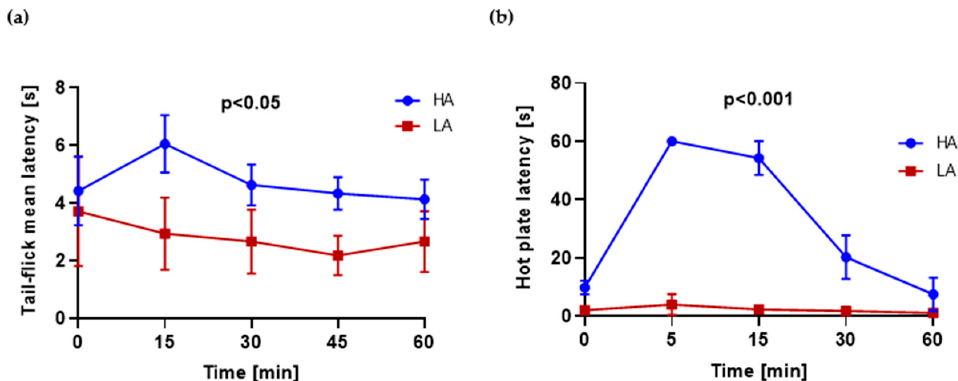
Figure 1. ( a ) Tail-flick latency in HA and LA mice ( n = 5) in time after swimming, average of three repetitions; ( b ) hot plate test in HA and LA mice, in time after swimming ( n = 5).